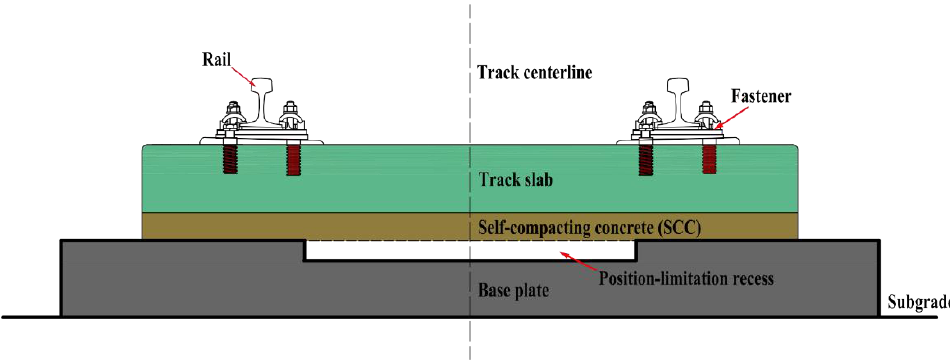
Figure 1. Schematic diagram of the CRTS III slab ballastless track structure.